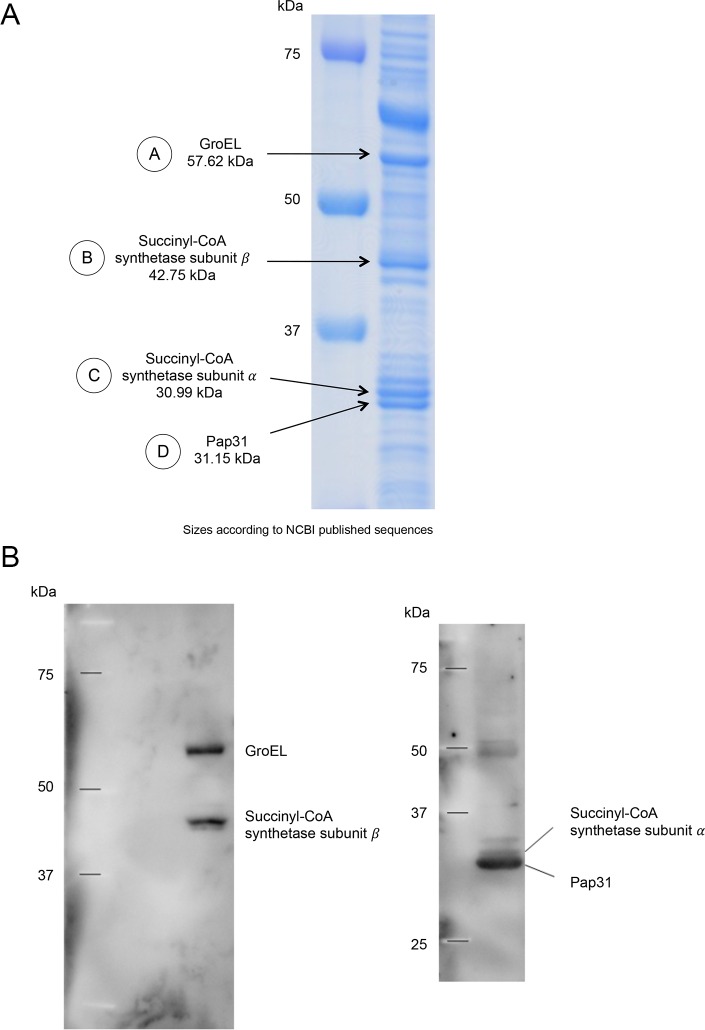
Antigenic candidates of B. bacilliformis selected.A) SDS gel with sonicated whole cell B. bacilliformis. B) Example of a Western blot with a positive serum by ELISA. The left panel corresponds to IgG and the right panel to IgM.